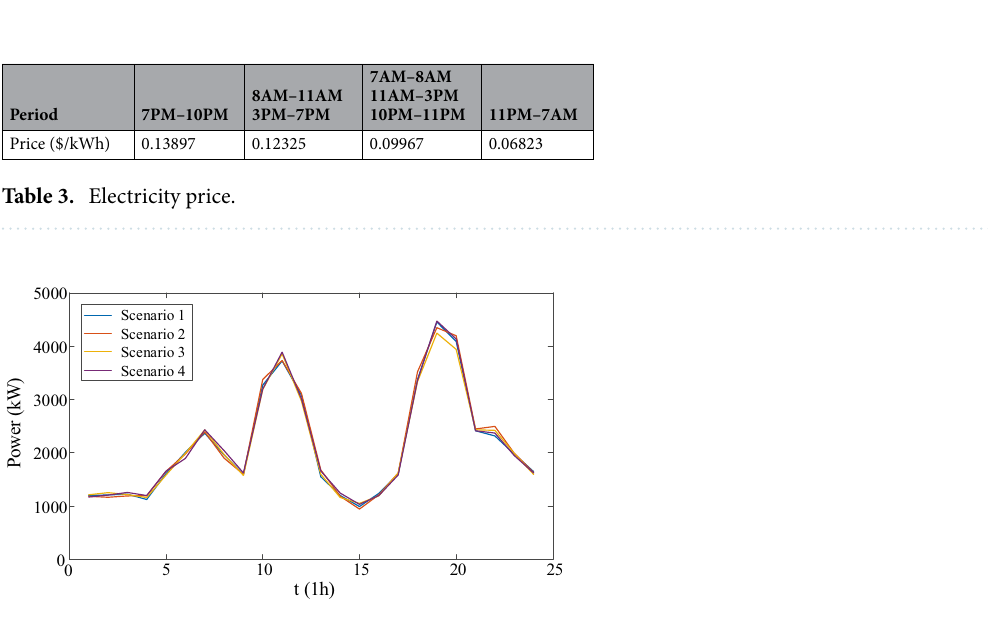
Figure 5. The scenario set of basic electrical